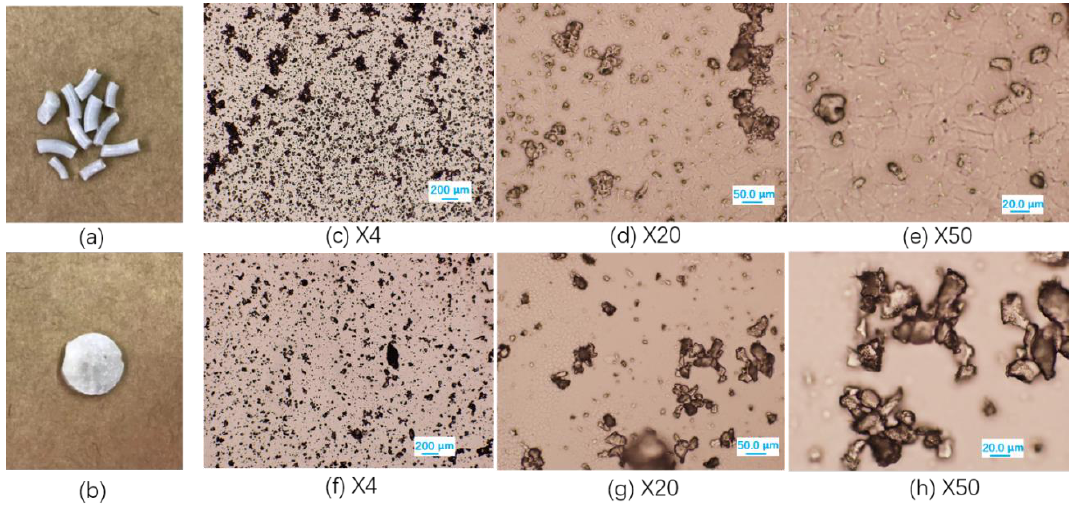
Figure 5. Photos of UP/polymer blends ( a ) from extrusion and ( b ) compression molding; optical microcopy images of urea phosphate crystal after processing ( c – e ) for UP-PBHS 30/70 blend; and ( f – h ) for UP-PBHS 70/30 blend at different magnification.